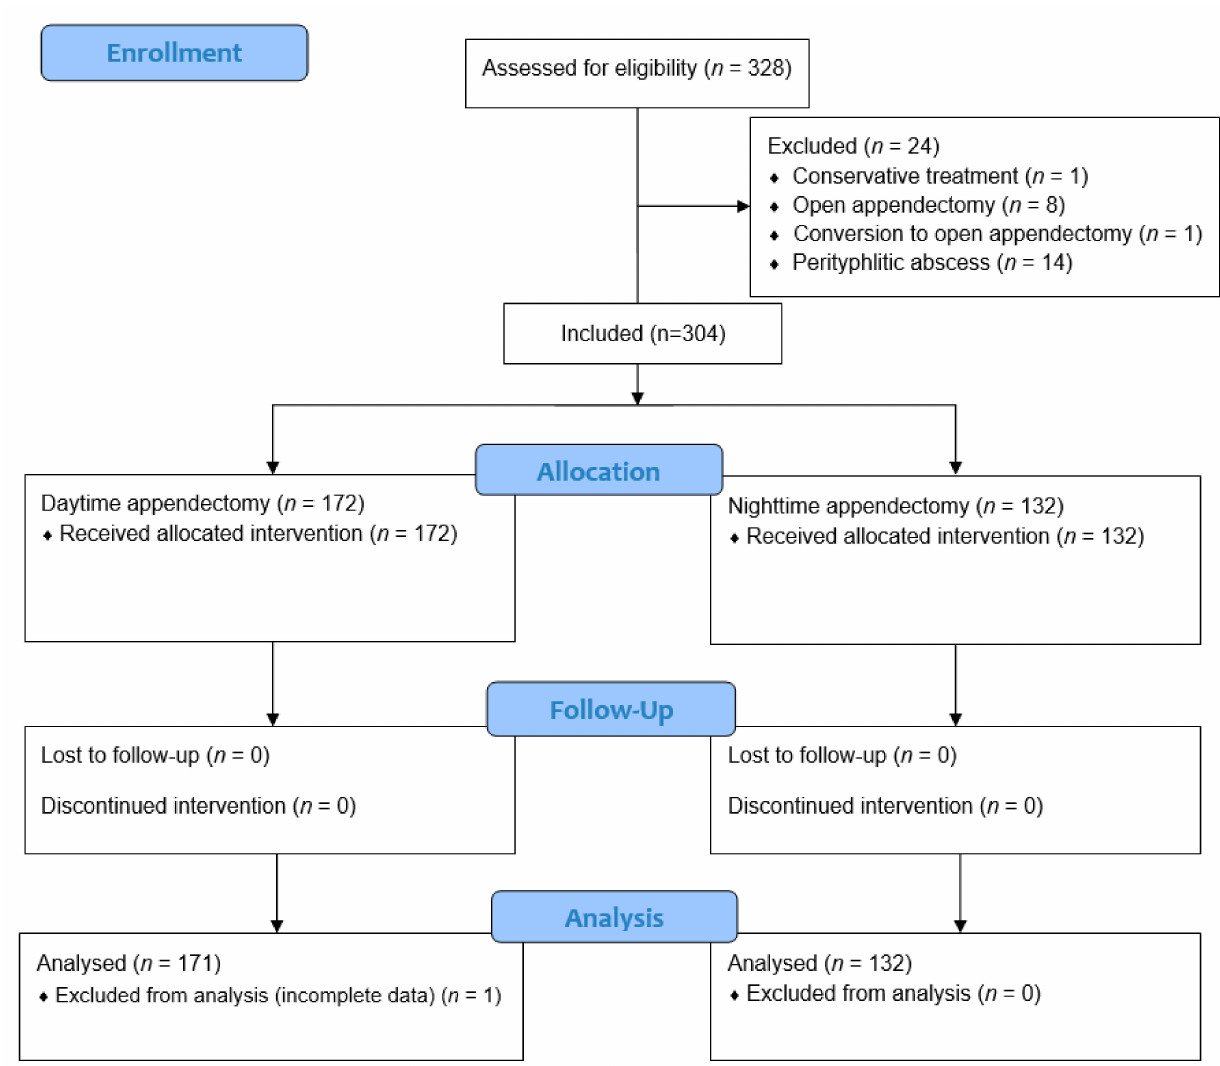
Figure 1. A flowchart diagram of the